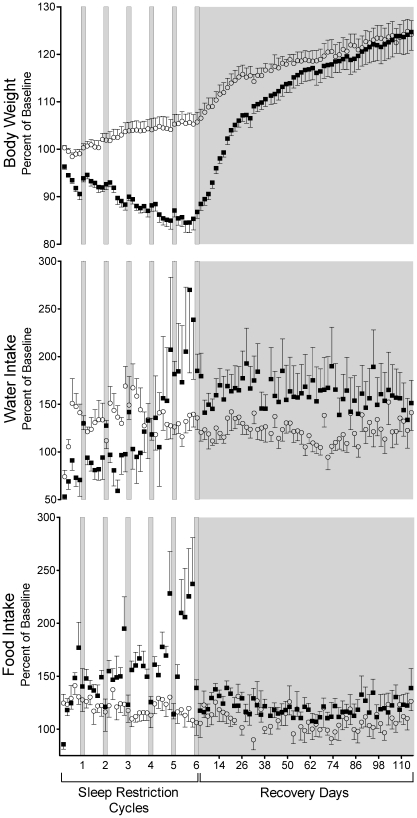
Dynamic effects on body weight, water intake, and food intake in rats resulting from 6 cycles of sleep restriction or ambulation control conditions followed by an extended recovery period.Data are expressed as a percentage change from baseline 2-day averages in sleep-restricted (▪) and ambulation control (○) rats. The first 72 days were arranged in 6 cycles, each composed of a 10-day period of sleep restriction or ambulation control (unshaded), followed by a 2-day period of ad libitum sleep (shaded bar). The subsequent 114 days were composed of ad libitum sleep conditions for recuperation (shaded area). See Results section for statistical comparison among groups and across time. Values are means (SE). n = 8 per group, except n = 7 for the sleep-restricted group during the last 2 sleep restriction cycles and during the prolonged recuperation period.